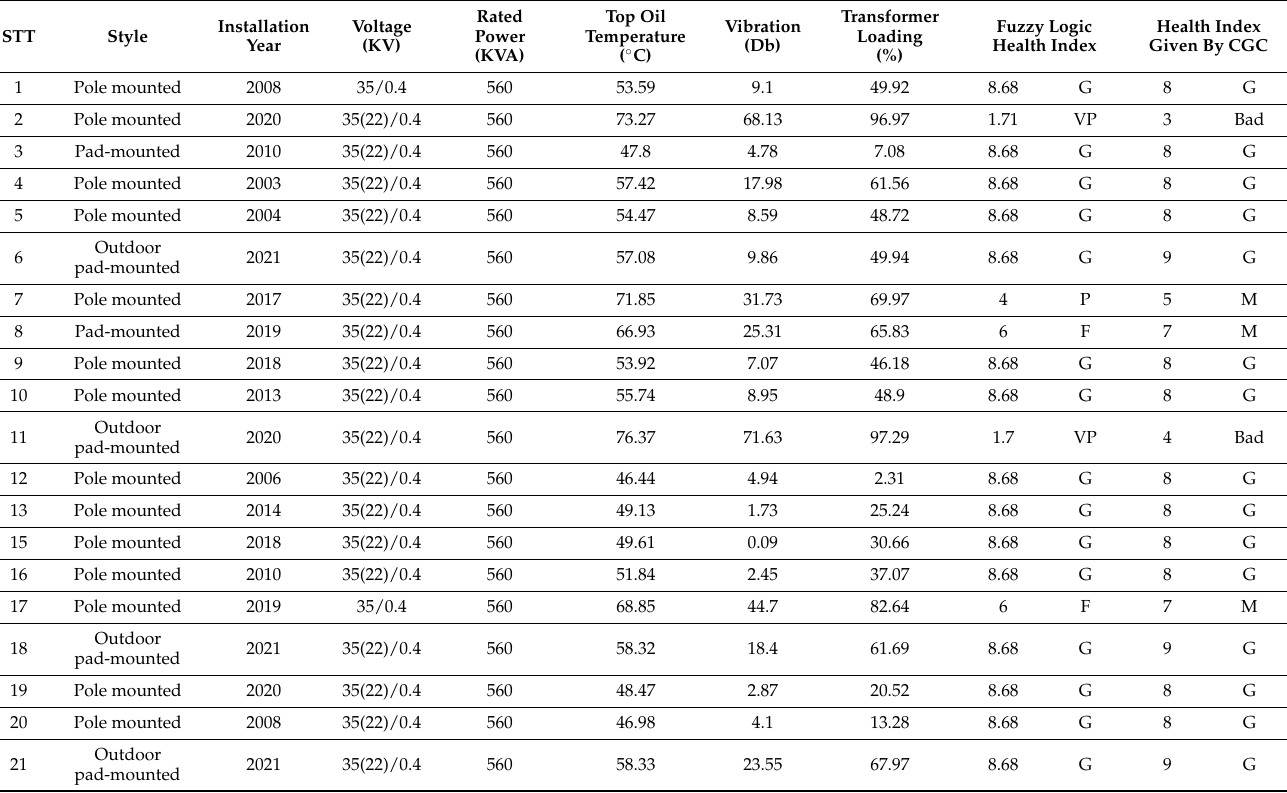
Table 4. Health index calculation for transformers 1 to 21 at CGC.